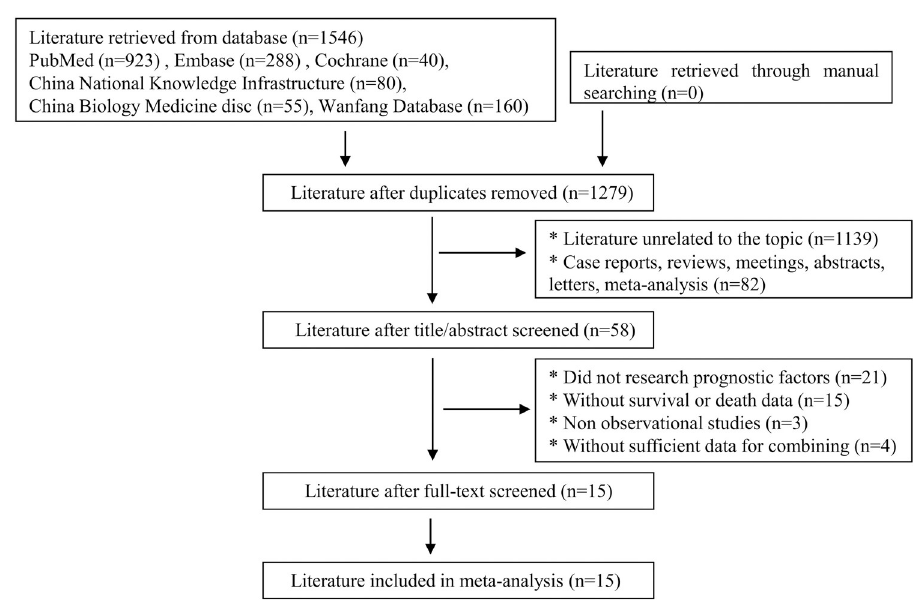
Fig 1. The flowchart of literature screening.